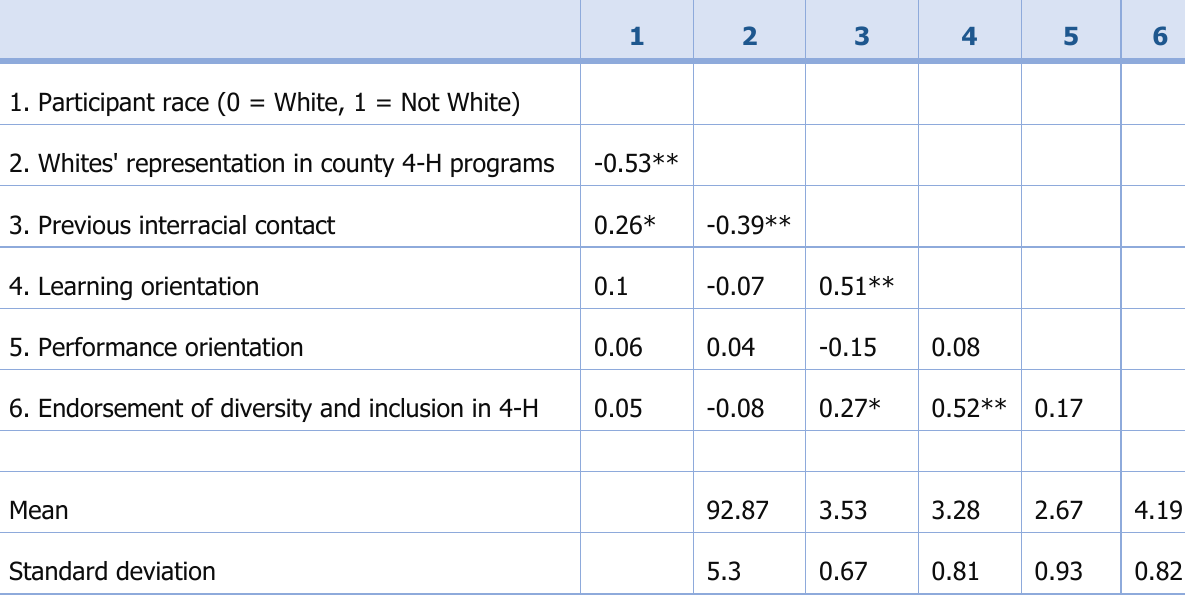
Table 1. Bivariate Correlations, Means, and Standard Deviations of Study